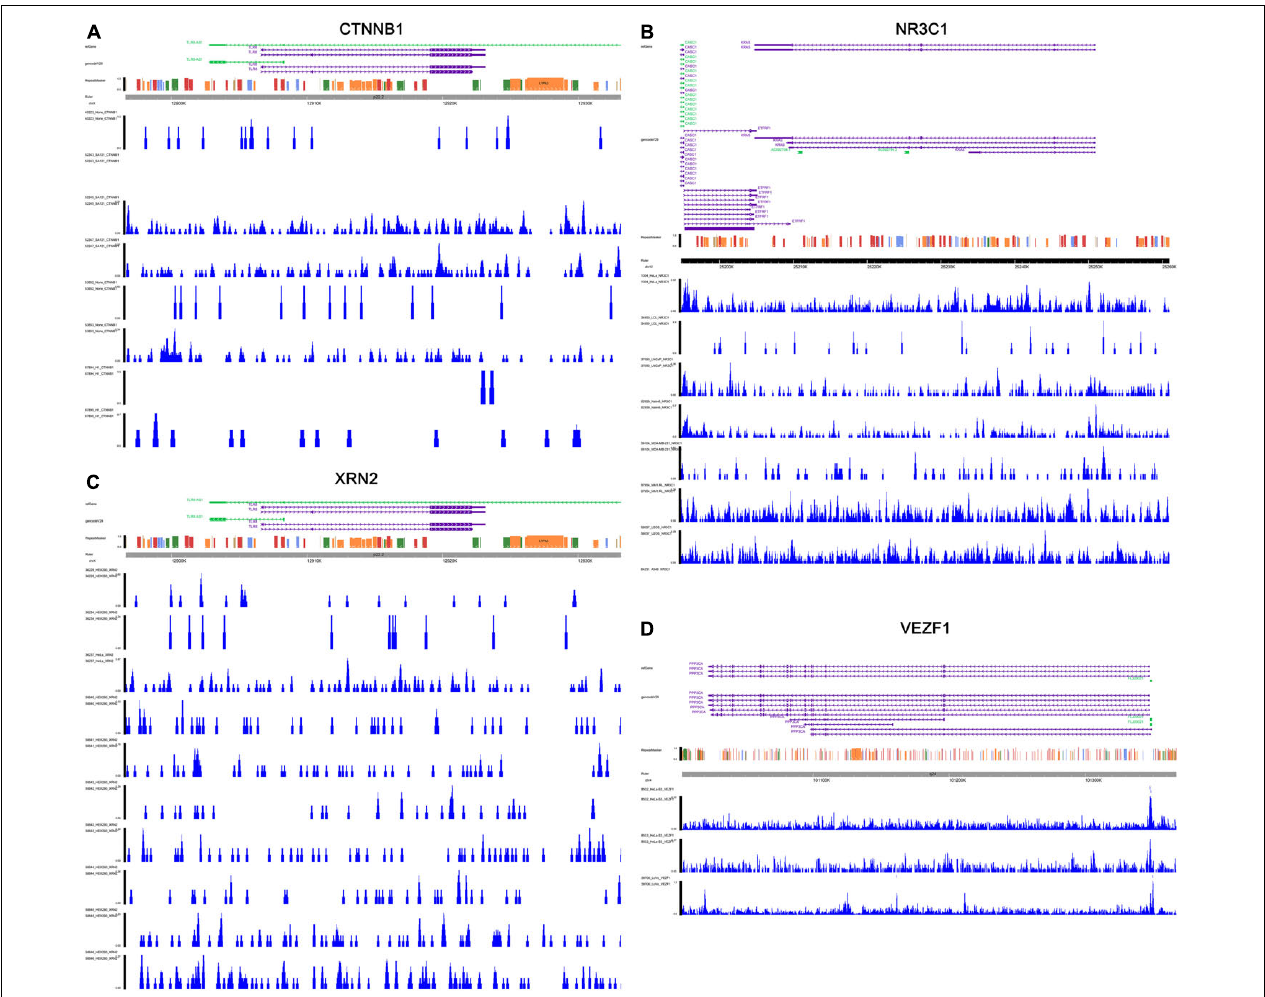
FIGURE 9 | Validation of the transcriptional regulation mechanisms of four TF-IRG pairs in ChIP-seq data available from Cistrome database. The transcriptional regulation mechanisms of four TF-IRG pairs [CTNNB1-TLR8 (A) , NR3C1-PPP3CA (B) , XRN2-TLR8 (C) , and VEZF1-KRAS (D) ] were validated by ChIP-seq data available from Cistrome